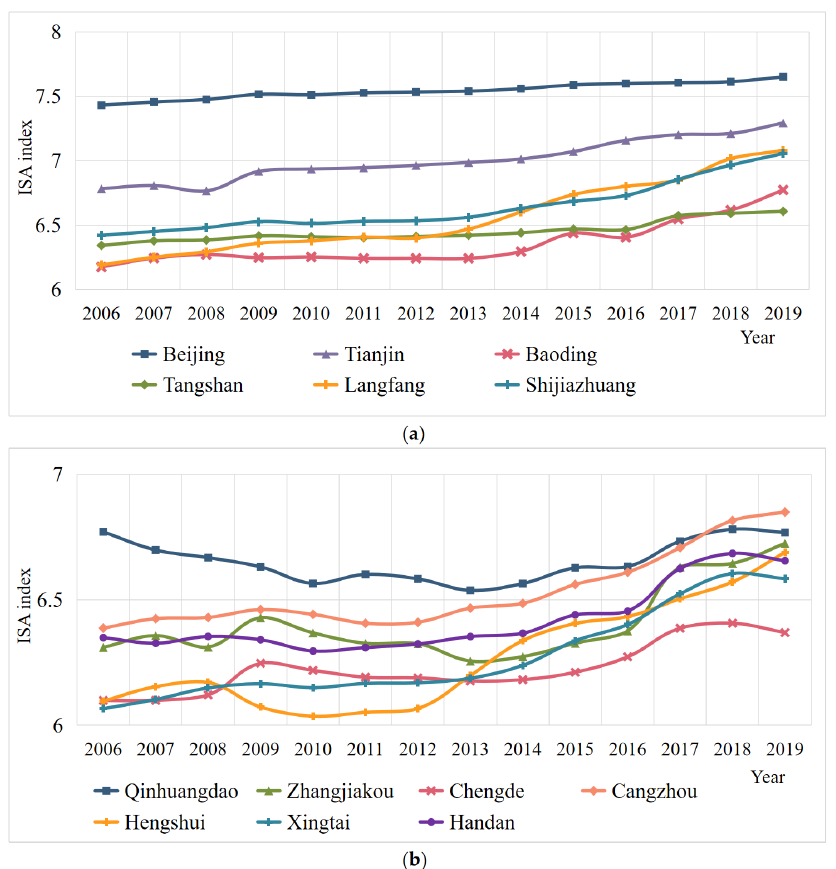
Figure 4. Temporal evolution of industrial structure advancement in BTH. ( a ) Temporal evolution of industrial structure advancement in Beijing, Tianjin, Baoding, Tangshan, Langfang and Shijiazhuang; ( b ) temporal evolution of industrial structure advancement in Qinhuangdao, Zhangjiakou, Chengde, Cangzhou, Hengshui, Xingtai and Handan. Figure source: authors’ own creation. Data from the China City Statistical Yearbook .